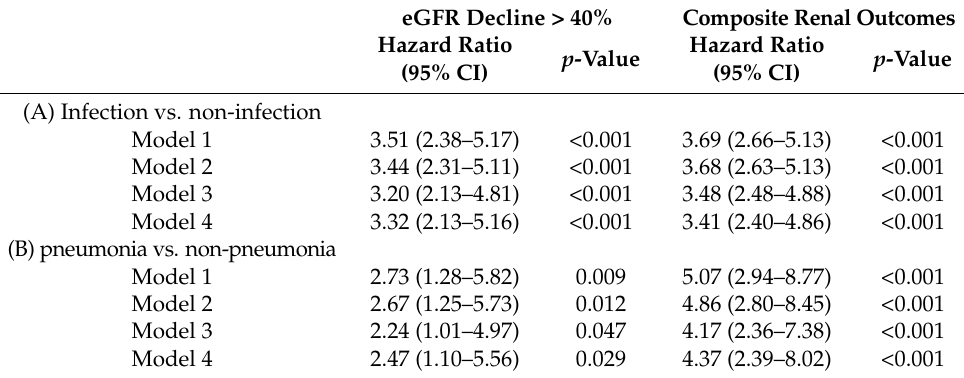
Table 3. Stepwise Cox regression models of renal outcomes for infection/pneumonia